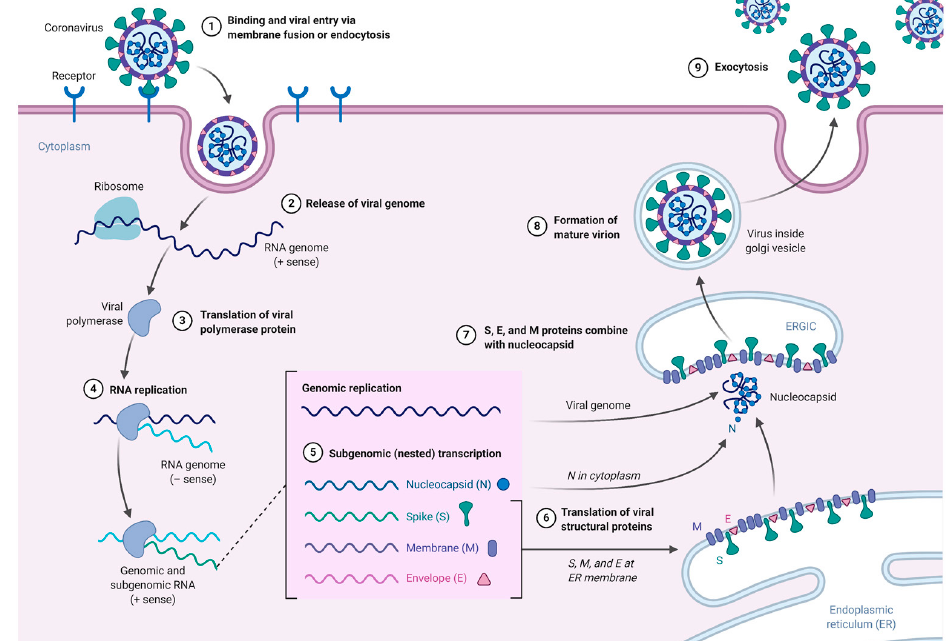
Fig. 2 . Representation of endocytosis and exocytosis-based Coronavirus entry and exit to and from the host, respectively. The Figure was created with “BioRender.com” template and exported under the terms of premium